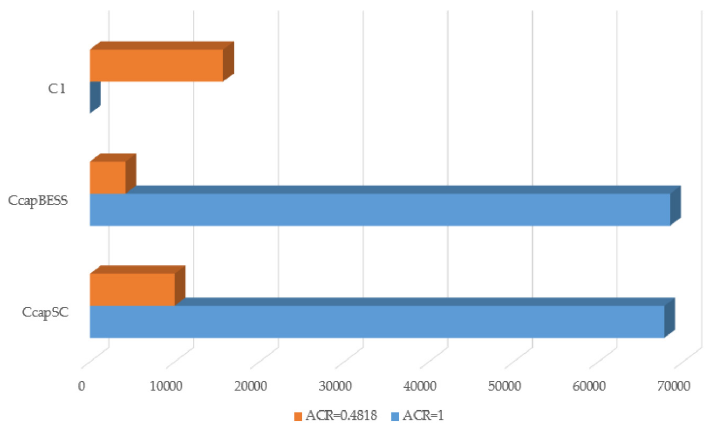
Figure 14. Calculation result at ACR = 1.